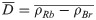
Equalization of the two kinds of hypocrites over time.The parameter values are the same as in Fig 3. The initial conditions are also the same for the corresponding shapes and colors. The vertical axis shows the absolute value of the mean difference D¯=ρRb−ρBr¯ on a logarithmic scale. The mean was obtained from 1000 independent realizations. The error bars are shown only where they are larger than the symbol sizes. The solid lines are theoretical predictions under the assumption that D¯ decays exponentially with rate e+i (Eq 6).